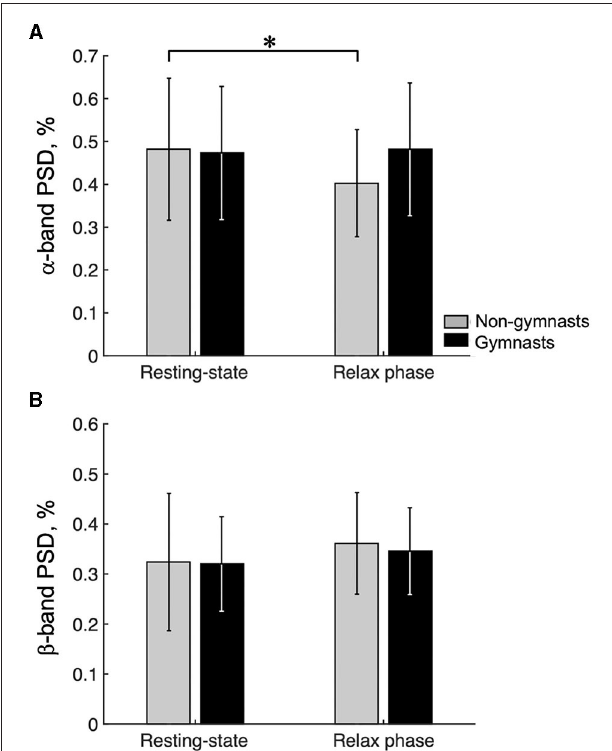
FIGURE 5 | Results of the ratio of the α -band and the β -band power spectrum densities. Group data (mean ± S.D.) for the ratio of the α -band (A) and β -band power spectrum densities (PSD) (B) are shown for both groups. The gray bars represent the data for non-gymnasts, while the black bars represent the data for gymnasts. * P <